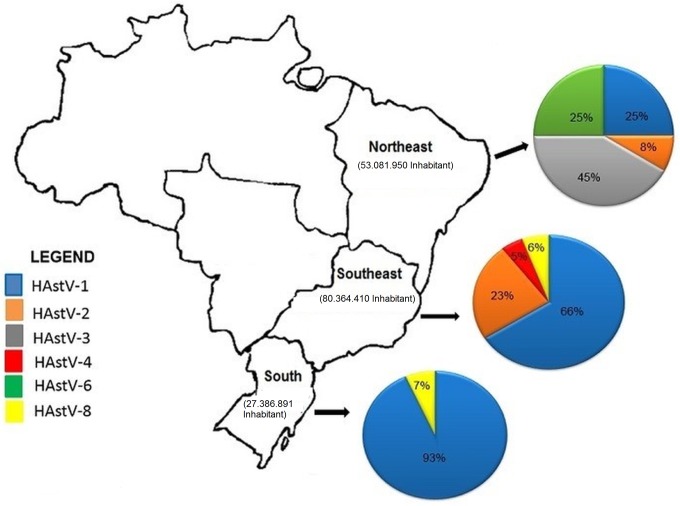
Map of the Brazilian coastal regions, showing the HAstV genotype distributions during 2005–2011.